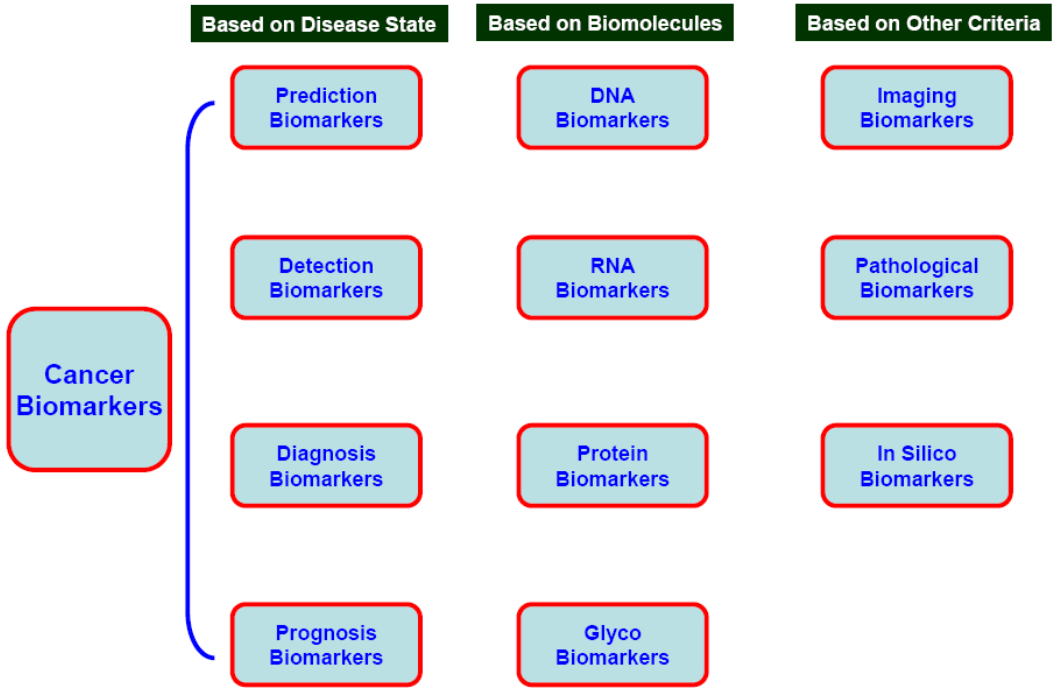
Figure 1. Classification of